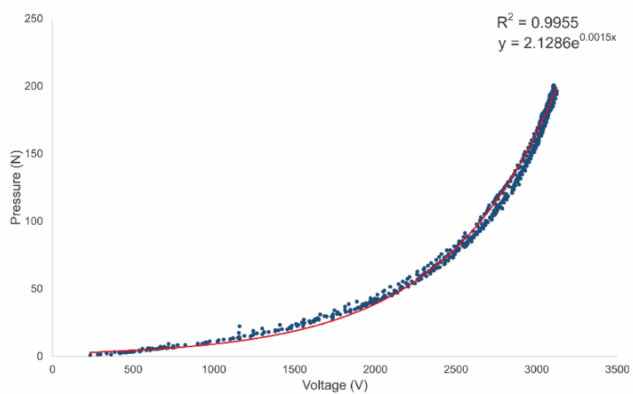
Figure 9. Sensor calibration result. Sensor output-pressure versus voltage.